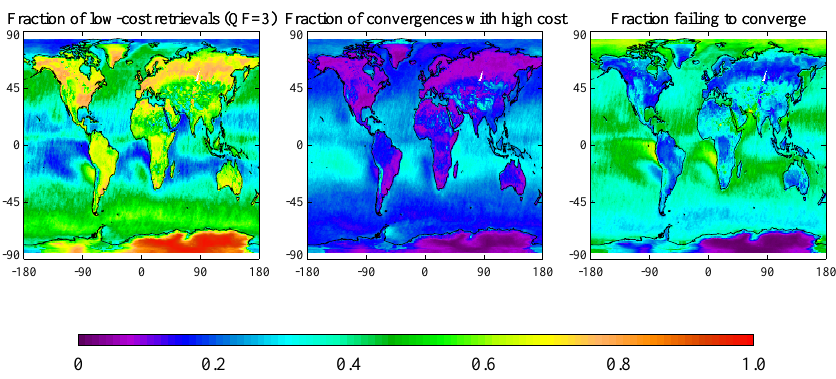
Fig. 2. Regional performance of cloud retrieval. From left to right are shown the fraction of attempted retrievals converging with cost of 10 or less (QF = 3); the fraction converging with a cost over 10; and the fraction failing to converge.